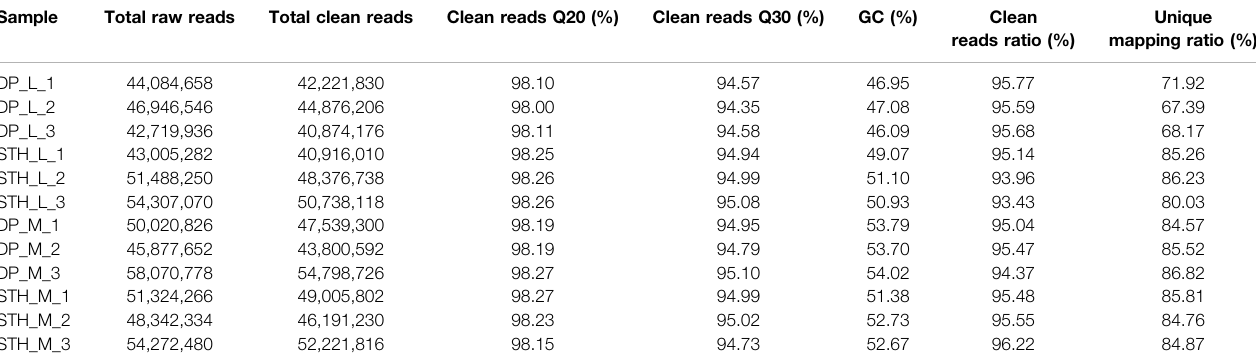
TABLE 1 | Statistical information of RNA-seq data in each sample.